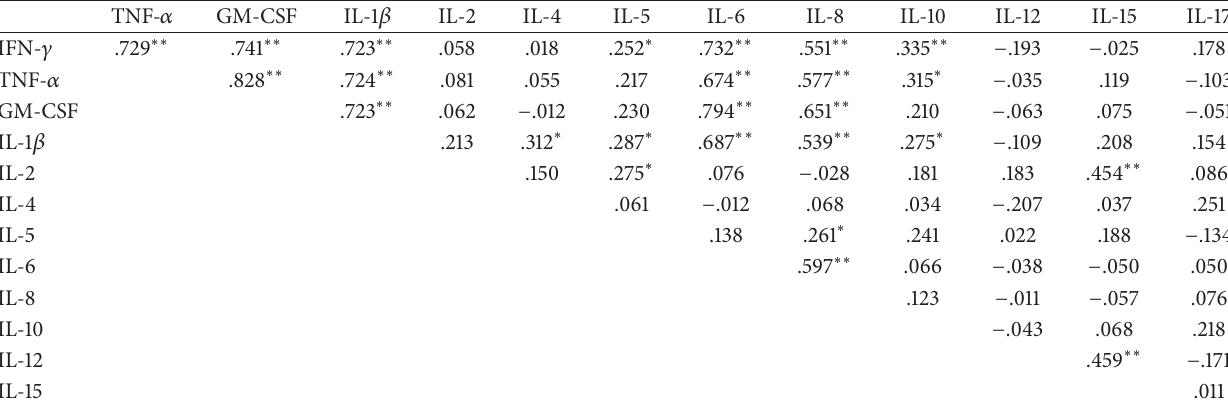
Table 3: Relationship between the serum levels of cytokines in adult patients with tuberculous lymphadenitis ( 𝑛 = 61 ) based on Spearman’s rank correlation. The values shown are the correlation coefficients.